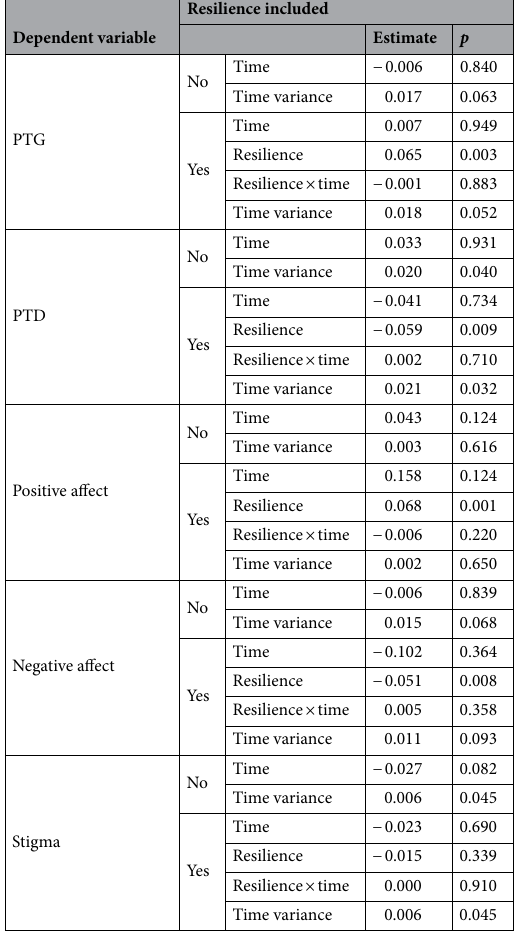
Table 3. Relationships between resilience, time, and daily levels of PTG or PTD, positive affect, negative affect, and HIV/AIDS stigma among